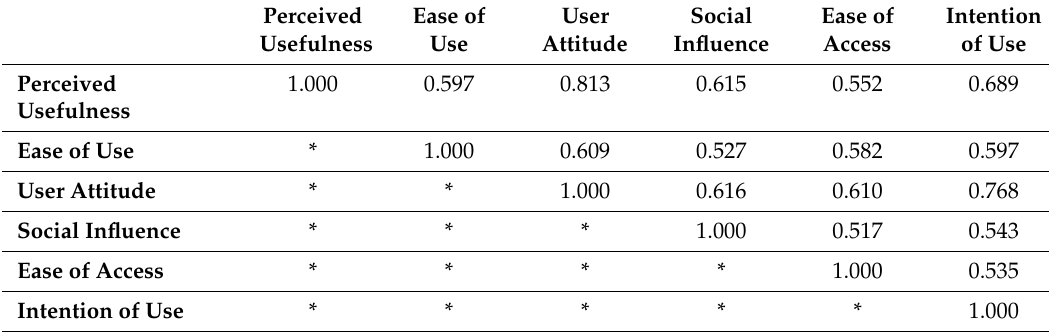
Table 5. Correlation matrix among the exposed